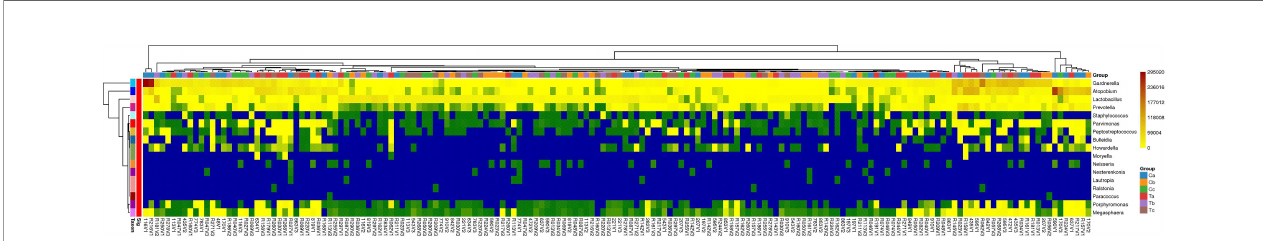
FIGURE 6 | Heatmap of the distributions of the 17 most abundant bacterial genera present in the vaginal swab samples. (The abscissa represents the sample, the ordinate represents different species at the genus level. The absolute abundances of bacterial genera are indicated by color intensity. Ta, Tb, and Tc represent stages V1, V2, and V3 of the Furong group, respectively; Ca, Cb, and Cc represent stages V1, V2, and V3 of the Clindamycin group, respectively).